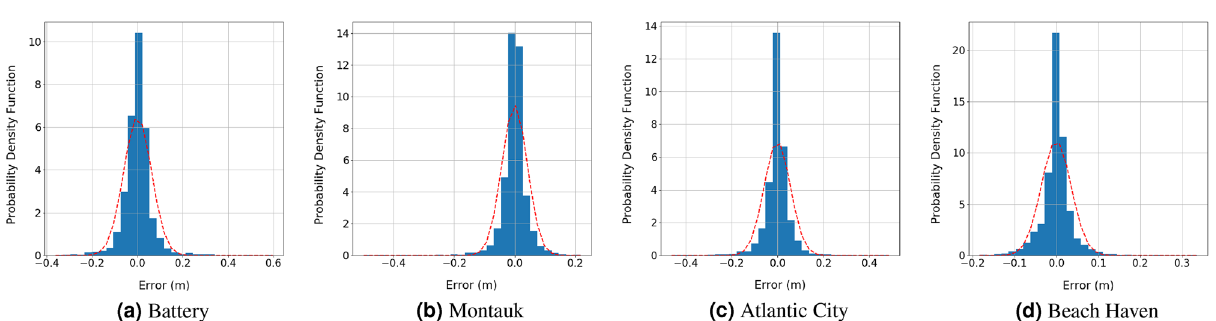
Figure 6. Histograms of the error between peak storm surge heights determined by the high-fidelity ADCIRC + SWAN simulations and those predicted from ML models at the four study